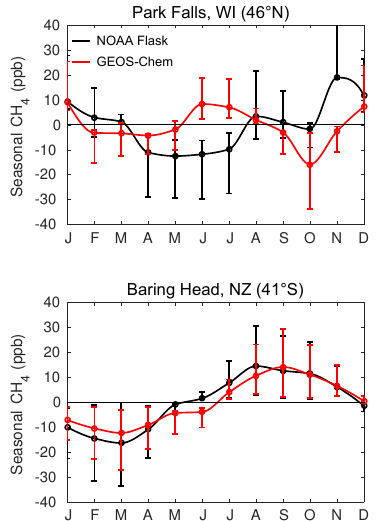
Figure 8. NOAA surface flask (black) and GEOS-Chem surface level (red) seasonality of CH 4 DMFs over 2005–2011 at Park Falls, WI, USA and Baring Head, NZ. Lower and upper bounds denote the 25th and 75th percentiles, respectively, of detrended data for each